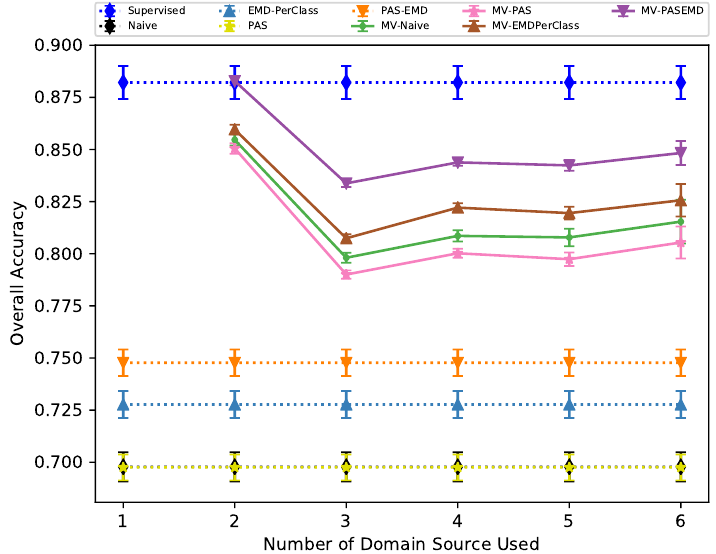
Figure 8. Overall Accuracy on the y-axis as a function of the number of source domain years used on the x-axis. Horizontal lines represent reference cases: supervised in blue, naive in black, PAS in yellow, EMD-PerClass in light blue and PAS-EMD in orange. Other curves represent the majority voting: MV-Naive in green, MV-PAS in pink, MV-EMD-PerClass in brown, MV-PAS-EMD in purple. As introduced earlier, standard measures are insufficient for the evaluation of voting